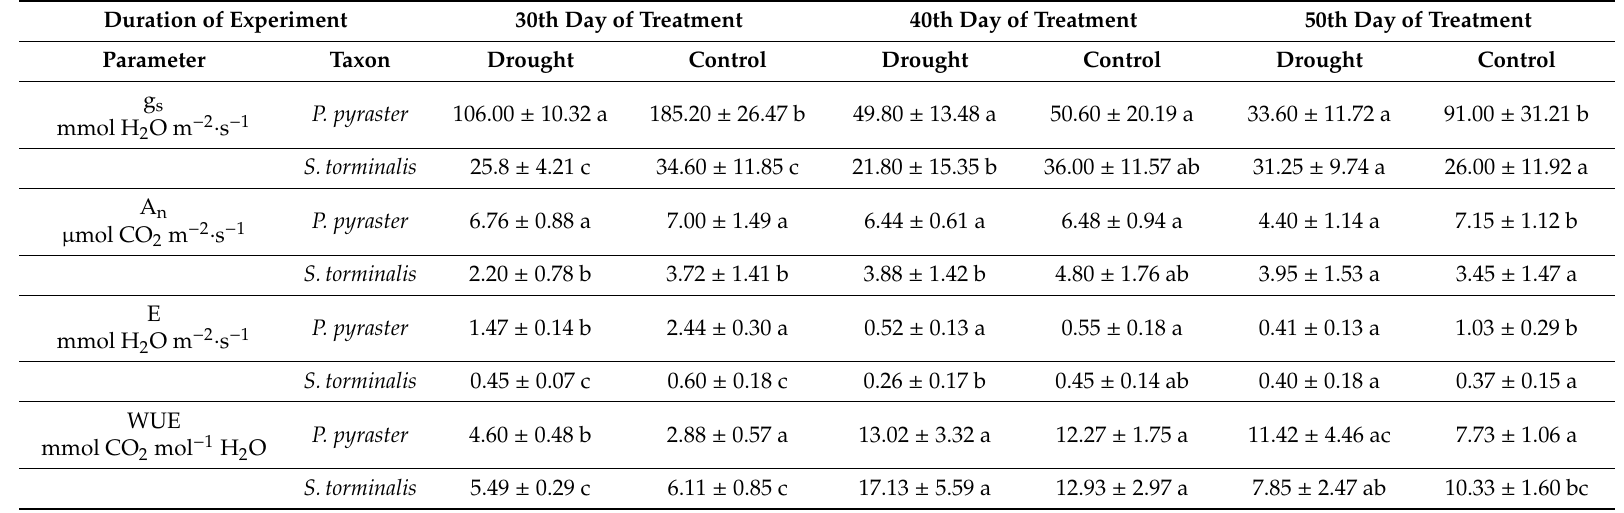
Table 3. The mean values and standard deviations ( ± SD) for the net assimilation rate (A n ), transpiration rate (E), stomatal conductance to water vapor (g s ), and water use e ffi ciency (WUE) of the P. pyraster and S. torminalis seedlings under di ff erent water regimes ( n = 5). The significant di ff erences between species and treatments are denoted by di ff erent